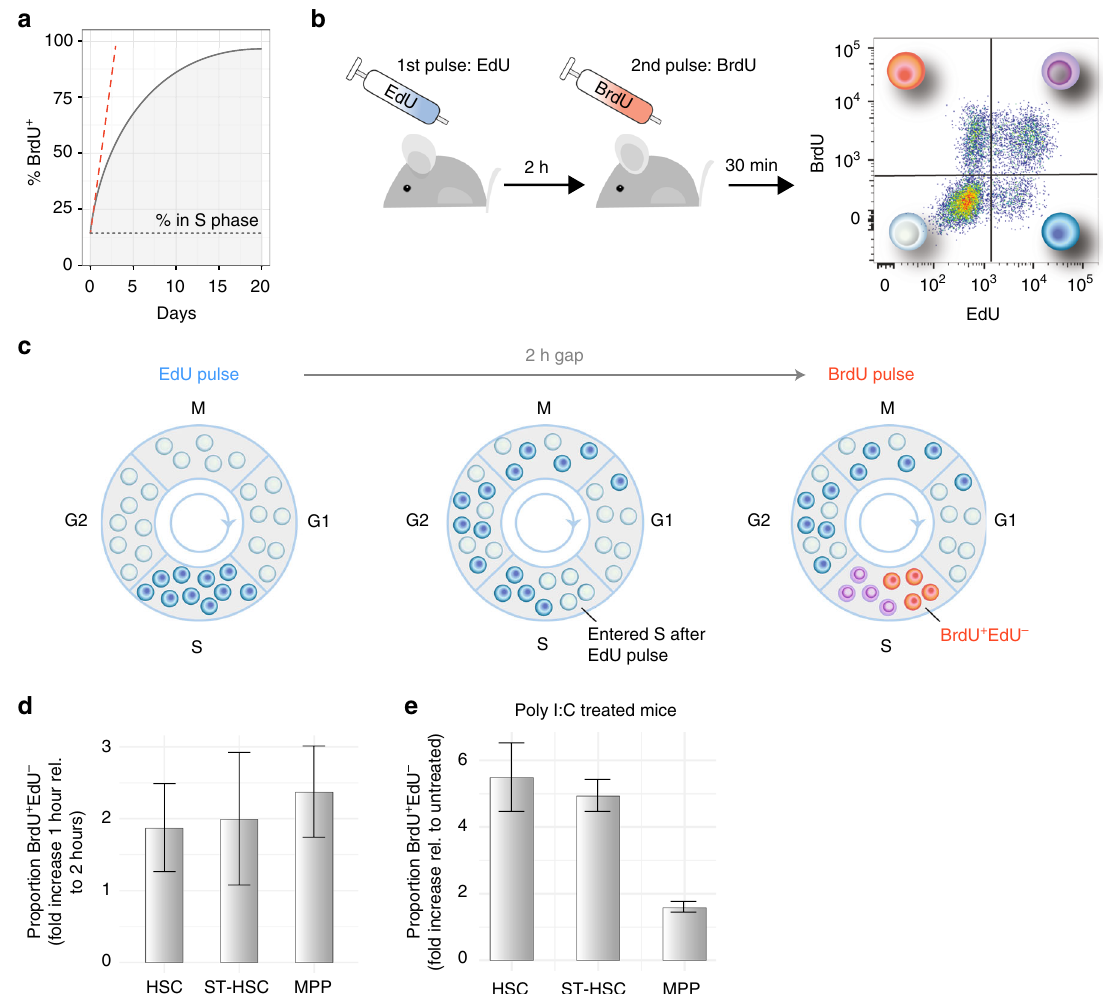
Fig. 2 EdU and BrdU dual pulse allows measurement of rate of entry into S phase of haematopoietic cell populations. a Assuming a constant proportion of cells are in S phase (black dotted line), continuous administration of BrdU alone leads to progressive accumulation of the thymidine analogue in a growing proportion of the cell population (black line). The rate of entry in S phase at the time of the fi rst administration is the derivative at the origin of the curve (dashed red line) and cannot be calculated from a single mouse. b Experimental setup: mice were administered EdU fi rst, then BrdU 2 h later, and 30 min later were culled, and haematopoietic cells were analysed by fl ow cytometry. c Diagram representing the dynamics of cell labelling. EdU fi rst labels all the cells in S phase (dark blue). In the 2-h gap, some of these cells progress through G2 and mitosis, while others continue to synthetise DNA (dark blue). In parallel, some unlabelled cells enter S phase (empty circles). BrdU again labels all the cells in S phase, with the following results: cells that entered S phase during the 2-h gap are BrdU single positive (orange circles), cells that were in S phase during both pulses are double positive (purple circles), and cells that terminated S phase prior to the BrdU pulse are EdU single positive (blue circles). d Validation of the dual-pulse method. A 2-h gap between pulses results in a 2-fold increase in the number of labelled cells compared to a 1-h pulse (shown is average ± s.e.m; p = 0.84 HSC, p = 0.99 ST-HSC, p = 0.61 MPP, Welch two-sample t -test; n = 3 mice with 1 h gap, and n = 3 mice with a 2 h gap). e Dual-pulse method can identify the changes in proliferation rate of cell populations. Mice were administered poly I:C prior to EdU and BrdU, 24 h prior to culling, and the proportions of S phase HSCs, ST-HSCs and MPPs were compared to those of control mice (average ± s.e.m shown; p = 0.04 HSC, p = 0.01 ST-HSC, p = 0.07 MPP, Welch two-sample t -test; n = 3 control and n